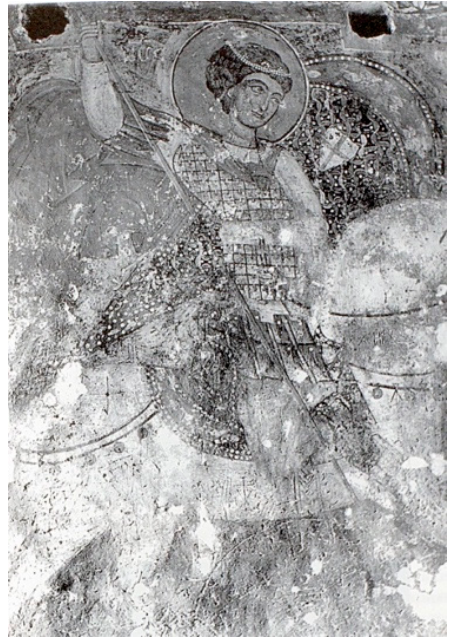
Figure 8. St George. Paintings in the Frankish gatehouse at Nauplio, ca. 1291–1311. Source: (Hirschbilchler